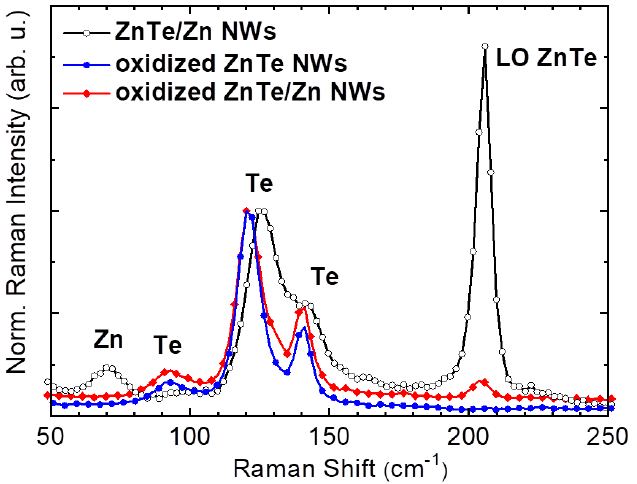
Figure 6. Raman scattering spectra of unprocessed (black circles) and oxidized ZnTe (blue points) and ZnTe/Zn (red diamonds) nanowires. These spectra are collected at ZnTe resonant conditions ( λ = 514 nm) and normalized to the Te feature at about 120 cm − 1